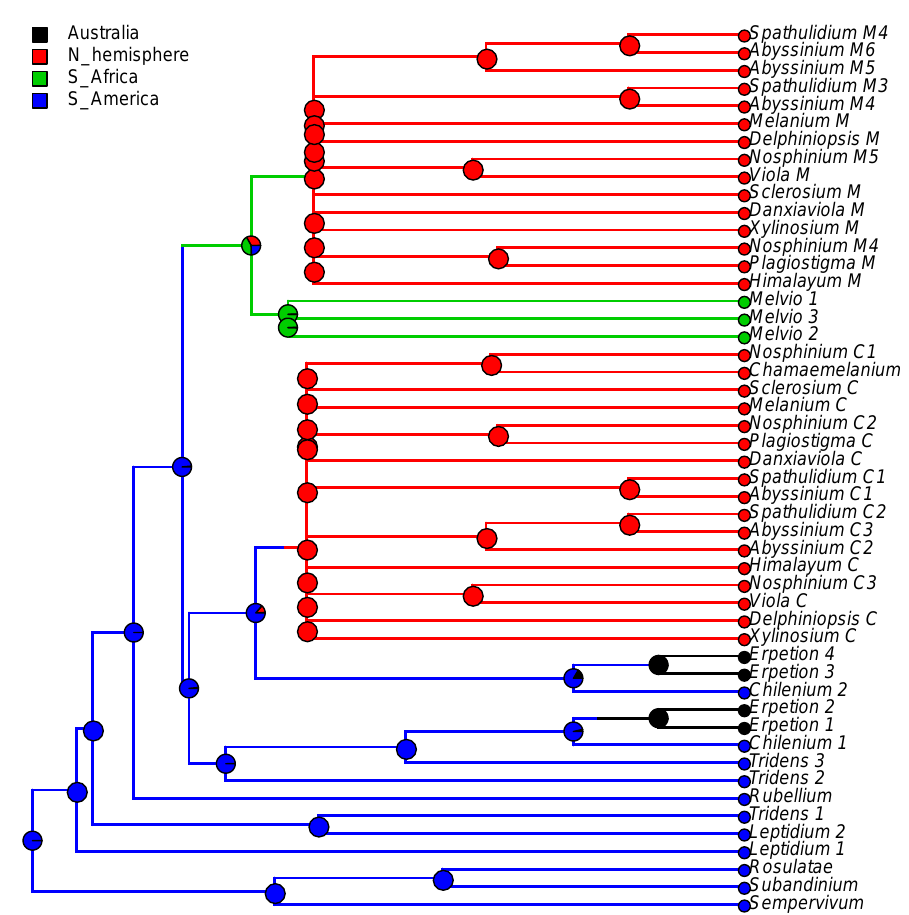
Figure 8. Discrete historical biogeography of Viola sections, showing the South American origin of the genus and independent dispersal into the northern hemisphere by the CHAM and MELVIO lineages. Ancestral states were inferred by stochastic character mapping [103] using a 1-rate model and 1000 replicates, given the monoploid multilabelled timetree with 50 leaves that results from unfolding the network in Figure 5 to a tree. Sections Nematocaulon (New Zealand) and Xanthidium (South America), for which data are lacking, are not